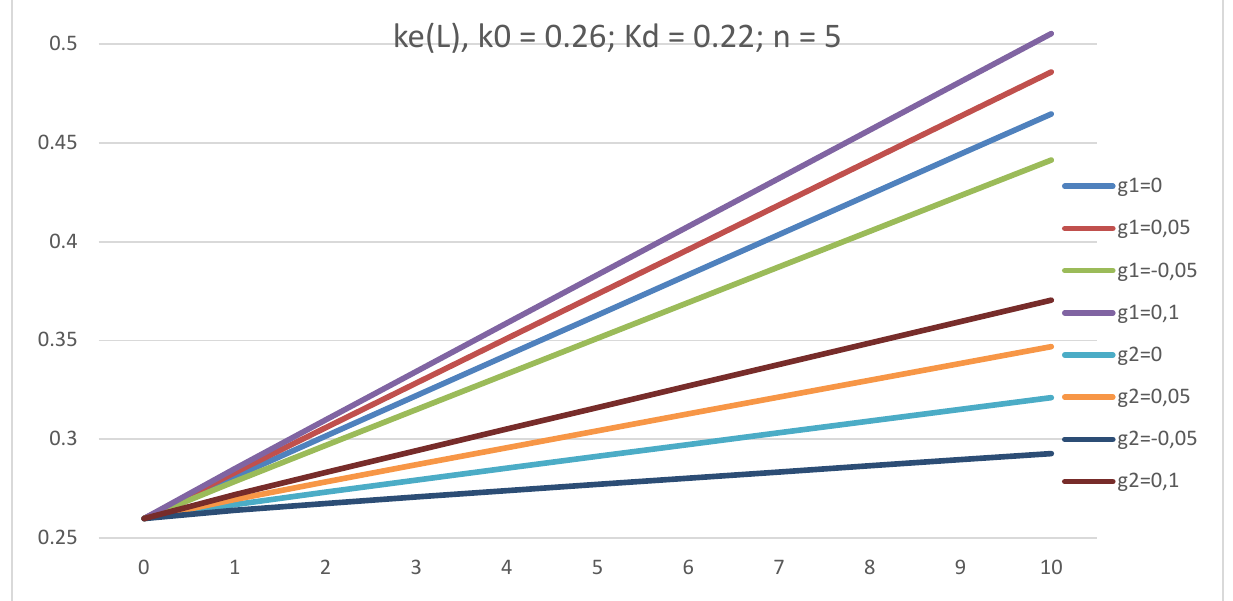
Figure 4. The dependence of equity cost, ke, on leverage level, L, in GBFO theory with payments of tax on profit at the end of periods (1) and advance payments (2) at k 0 = 0.26; k d = 0.22; t = 0.2; g = 0.1; 0.05; 0.0; − 0.05 for a five-year company.